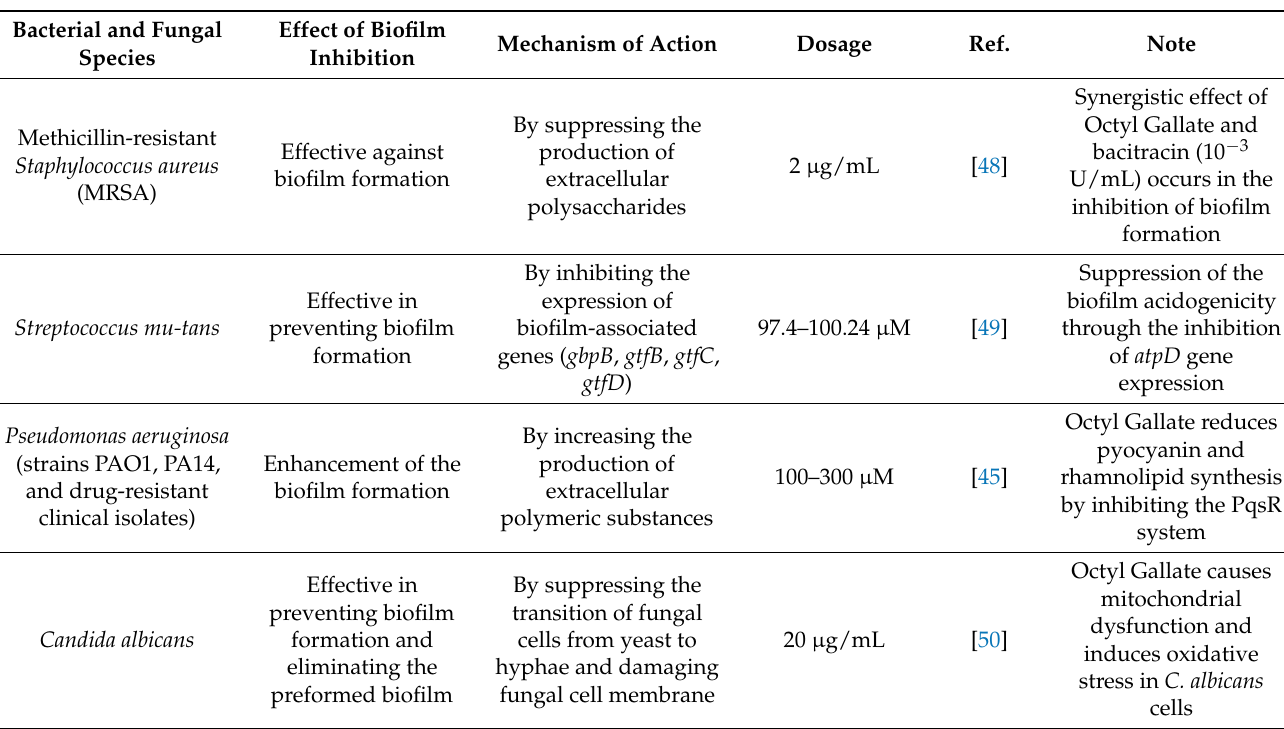
Table 5. Octyl Gallate inhibition of biofilm formation by several bacterial and fungal species and its suggested mechanisms of